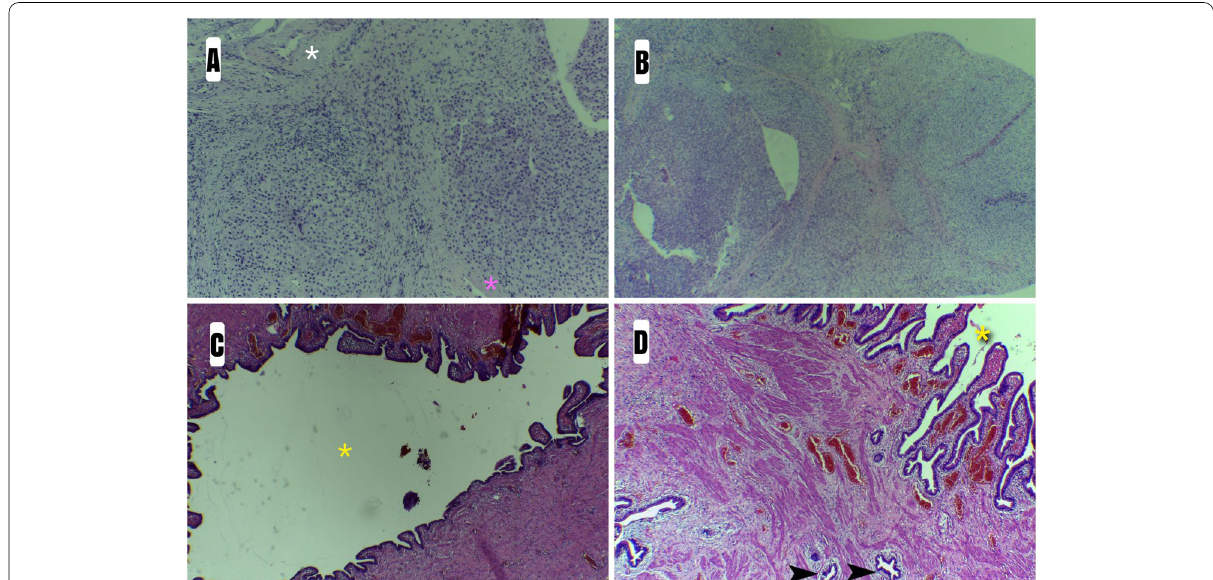
Fig. 4 A – D : Hematoxylin and eosin (H&E) stain of hepatic and bile duct tissue. ( A ) 20 purple asterisk showing the portal triad and central vein, respectively). ( B ) 4 ( C ) 4 showing a cysticly dilated duct (yellow asterisk) with subepithelial chronic inflammatory cell infiltrates and fibrosis. ( D ) 20 × section of the bile duct with a portion of the main cysticly dilated lumen (yellow asterisk) and smaller ducts (black arrowheads) lined by columnar epithelium. The duct walls are composed of dense fibrous tissue as well as scattered smooth muscle